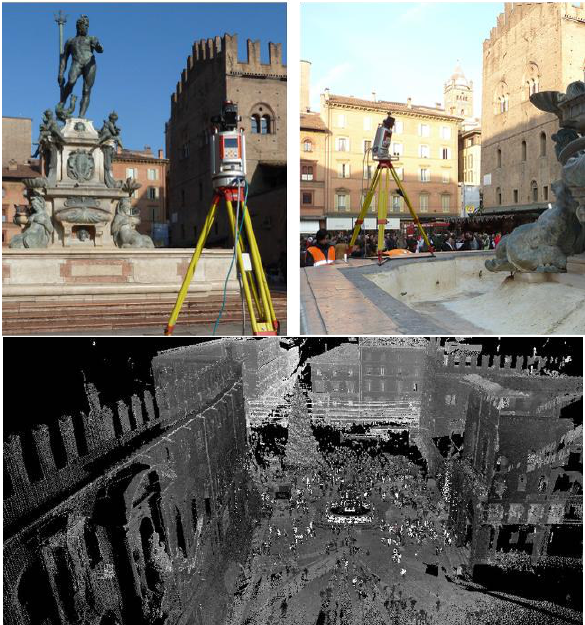
Figure 1. The fountain of Neptune, placed in the square of the same name in the centre of Bologna. Figure 2. Two moments of the laser scanning survey (top); one of the acquired point cloud